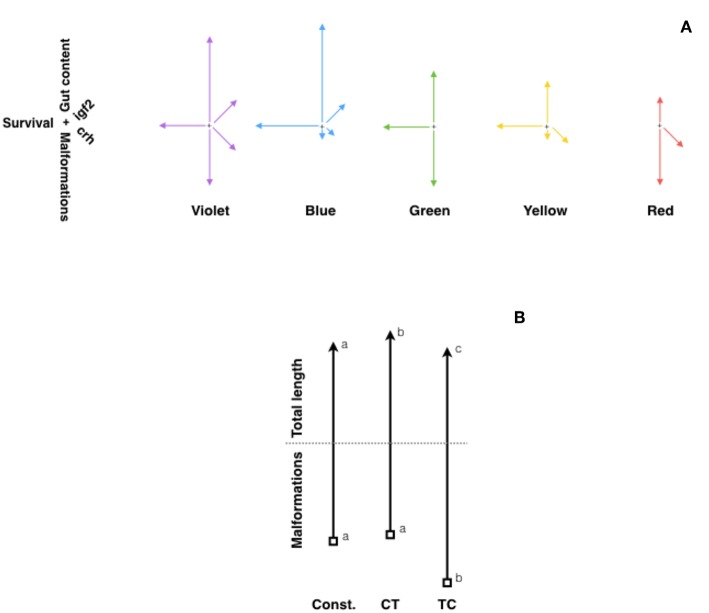
Fitness diagrams of (A) zebrafish exposed to different light spectrum (violet, blue, green, yellow, and red), and (B) Senegalese sole larvae at 30 DPH raised under constant temperature (21.5°C), or two daily thermocycles: TC (22°C-day:19°C-night) or CT (19°C-day:22°C-night). In (A), lines represent relative values for malformations (vertical, downwards arrow), survival rate (horizontal, left arrow), gut content (vertical, upwards arrow), and expression of igf2 (rigth-up) and crh (right-down) genes. Modified from Villamizar et al. (143). In (B), vertical upwards arrows represent relative values for total length, while downwards arrows represent malformation rates. Different letters indicate significant differences. Modified with the permission of authors from Blanco-Vives et al. (141).